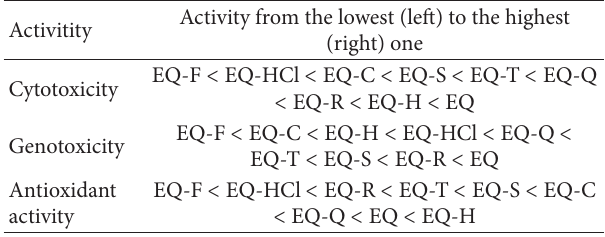
Table 5: Comparison of different activities of ethoxyquin and its derivatives based on the data presented by Błaszczyk and Skolimowski [19, 71, 80–82] and Błaszczyk et al. [79]. Activity from the lowest (left) to the highest Activitity (right) one Cytotoxicity